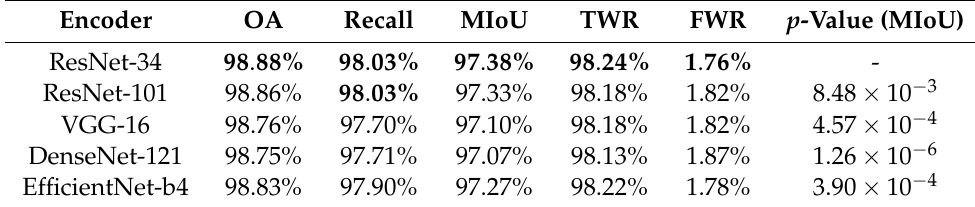
Table 5. The quantitative results of comparing the proposed method with different encoders.